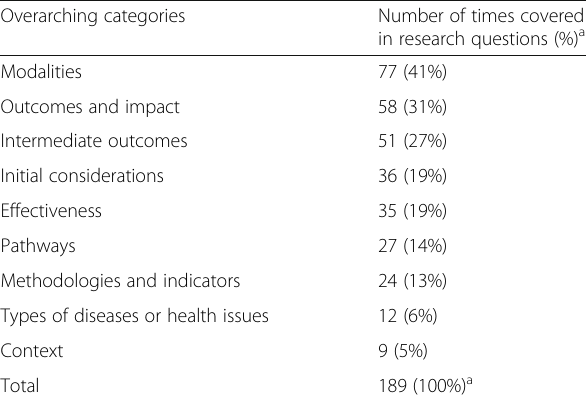
Table 4 Number of consulted research questions for each overarching category of research area Overarching